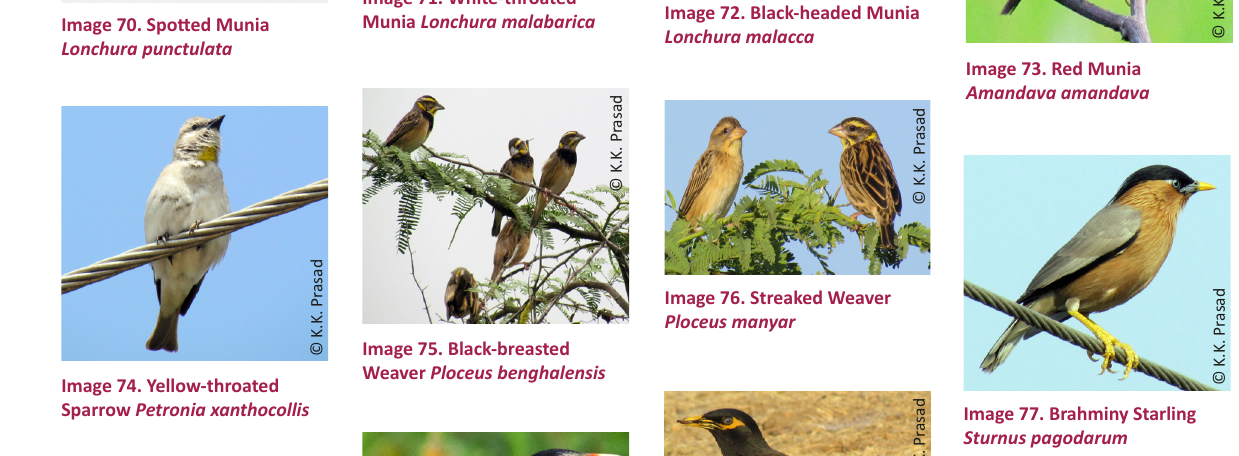
Image 71. White-throated Munia Lonchura malabarica